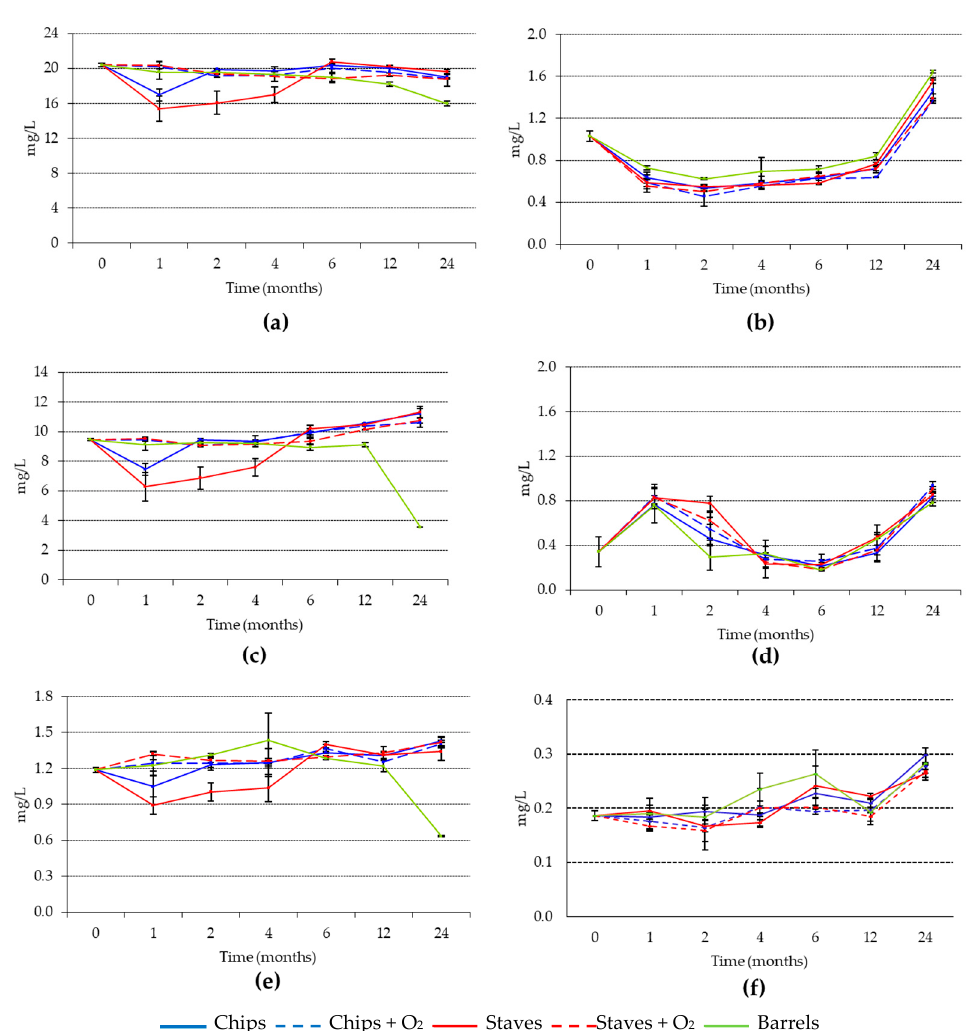
Figure 6. Evolution of cinnamic acids concentration (mg/L) over time: ( a ) caffeic acid; ( b ) caftaric acid; ( c ) coumaric acid; ( d ) coutaric acid; ( e ) ferulic acid; and ( f ) fertaric acid. Mean ± standard deviation ( n = 2).